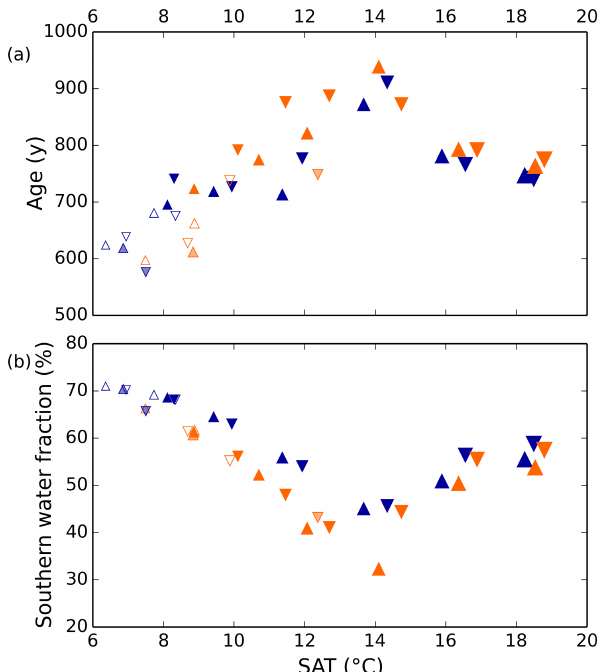
Figure 2. Simulated global ocean ventilation and proportion of southern-sourced deepwater. The horizontal axis shows the glob- ally averaged surface air temperature (SAT). (a) The global ocean average ideal age (low age corresponds to rapid ventilation) and (b) the fraction of water in the global ocean originating from the surface south of 30 ◦ S are anti-correlated over the range of SAT in these model runs. Orange and blue symbols represent high and low obliquity scenarios, respectively; triangles pointing upward and downward represent greater Northern and Southern hemisphere sea- sonality (precession 270 and 90 ◦ ); outlines are scenarios with LGM ice sheets; light shading indicates scenarios with LGM ice sheet to- pography but PI albedo. The size of the symbols corresponds to the